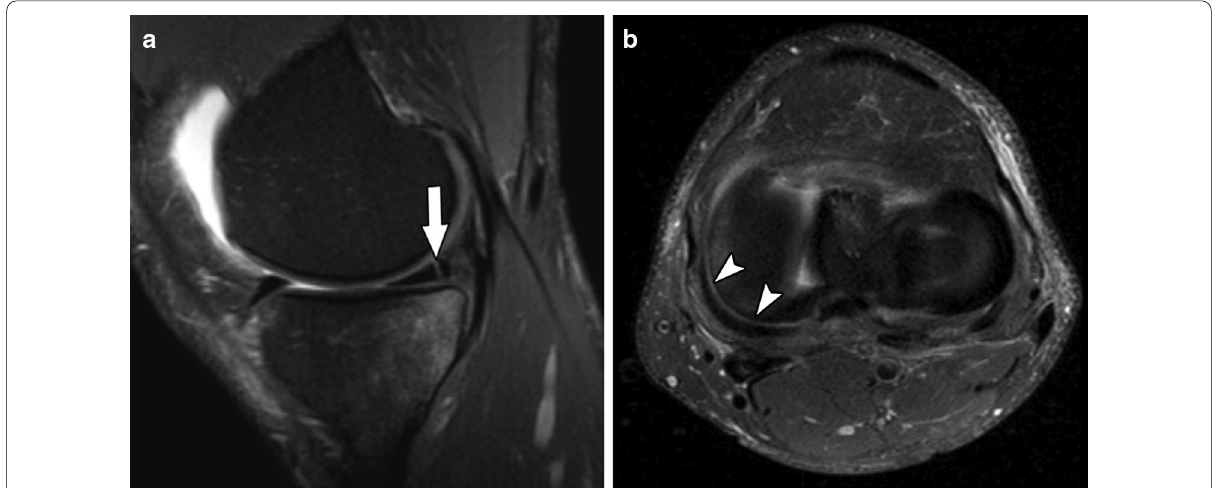
Fig. 11 Type 4A meniscal ramp lesion MRI Case. Sagittal ( a ) and axial ( b ) T2‑weighted fat‑suppressed MR image shows a type IV ramp lesion, with tear extending from femoral to tibial articular surfaces (arrow); tear extension is seen in ( b )